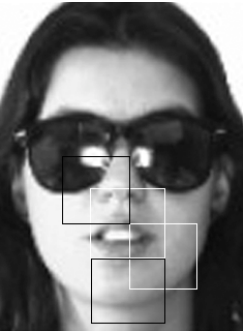
Figure 2. Example of overlapping patches of an image from the AR dataset.